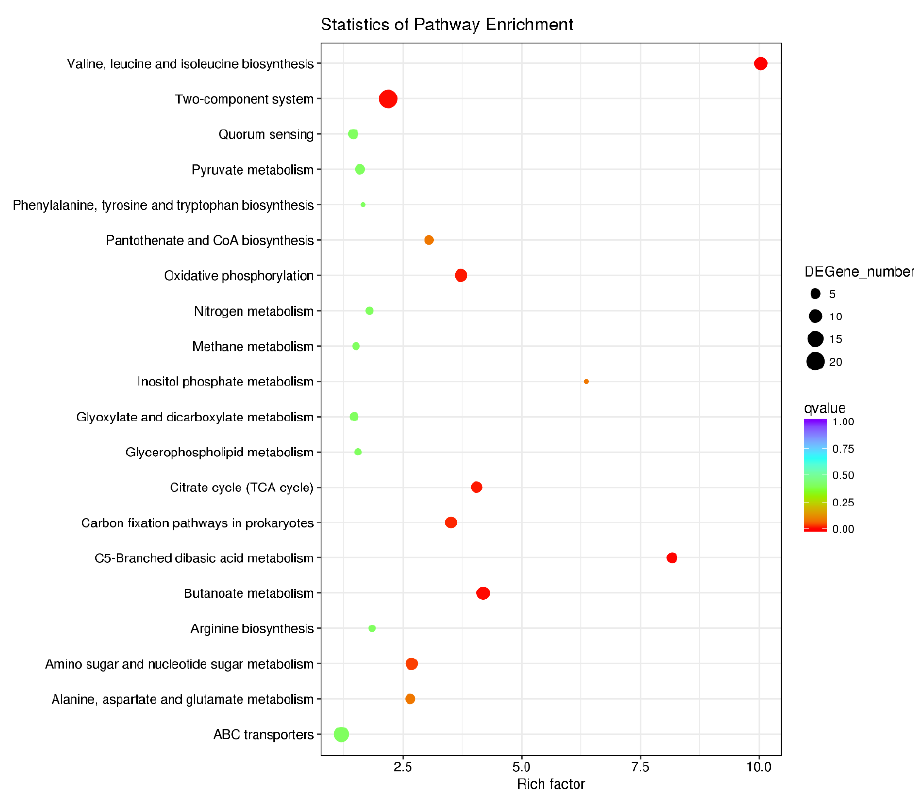
Figure 6. Enrichment analysis of KEGG pathways for DEGs. The top 20 enriched KEGG pathways were displayed. The size of each circle represents DEGs number in each pathway. The colour represents the corrected q value of each pathway.